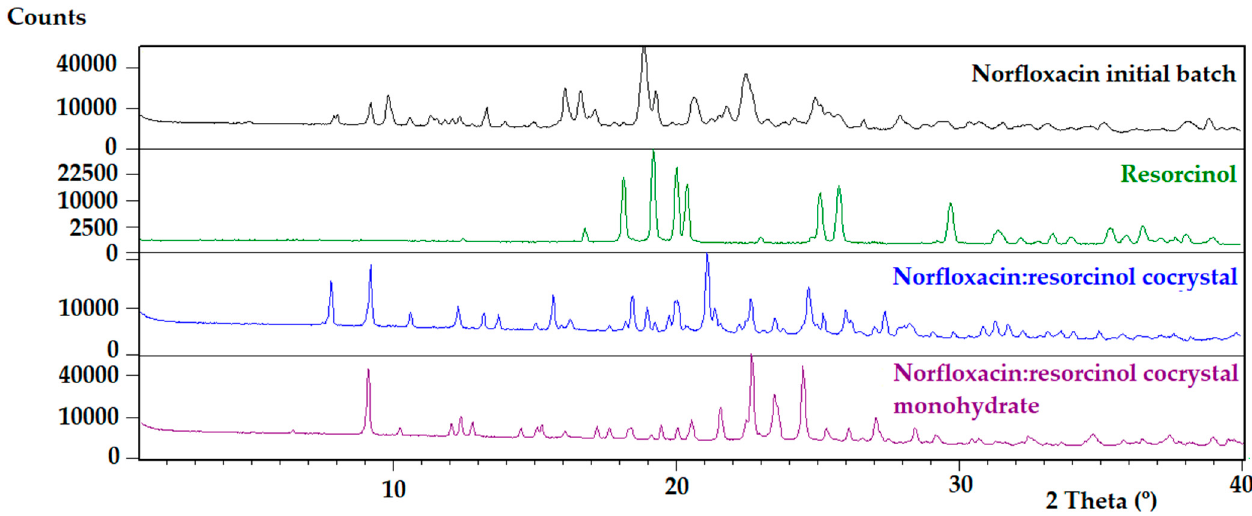
Figure 3. Pattern matching refinement of the Norfloxacin–resorcinol cocrystal monohydrate. Agree- ment factors: R wp : 6.5%; R exp : 1.8% (Chi 2 = 13 Experimental XRPD profile (red marks), calculated XRPD profile (black solid line) and the difference between them (blue, line). Tick marks correspond to peak positions (|, in green).